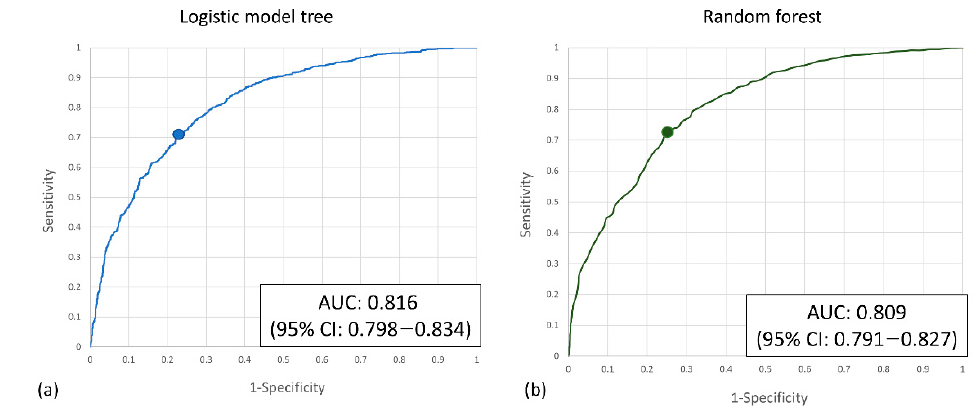
Figure 3. ( a ) The ROC curve of the logistic model tree model and ( b ) the random forest model.